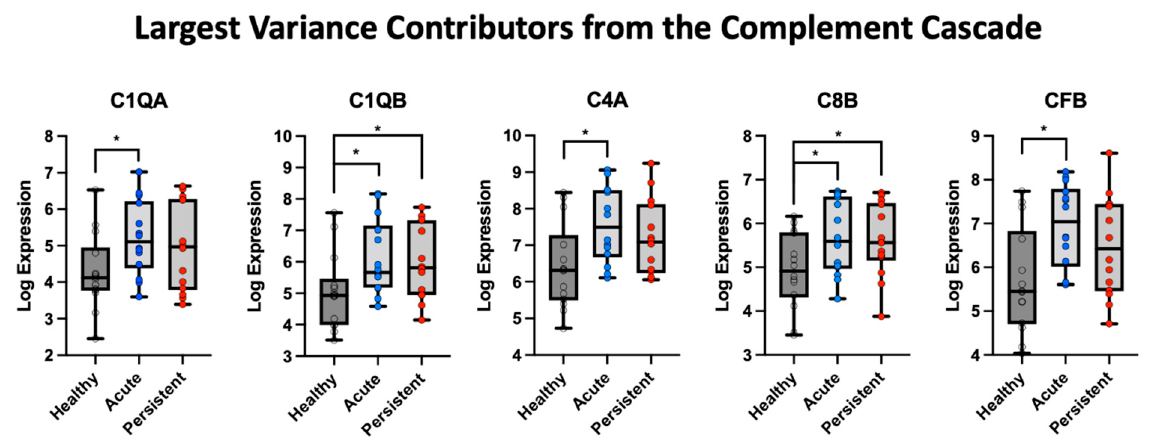
Figure 4. Five highest contributions to the first component from the PCA analysis of the complement cascade. The log expression values were evaluated in each cohort relative to healthy control data, with * indicating a p -value less than 0.05.